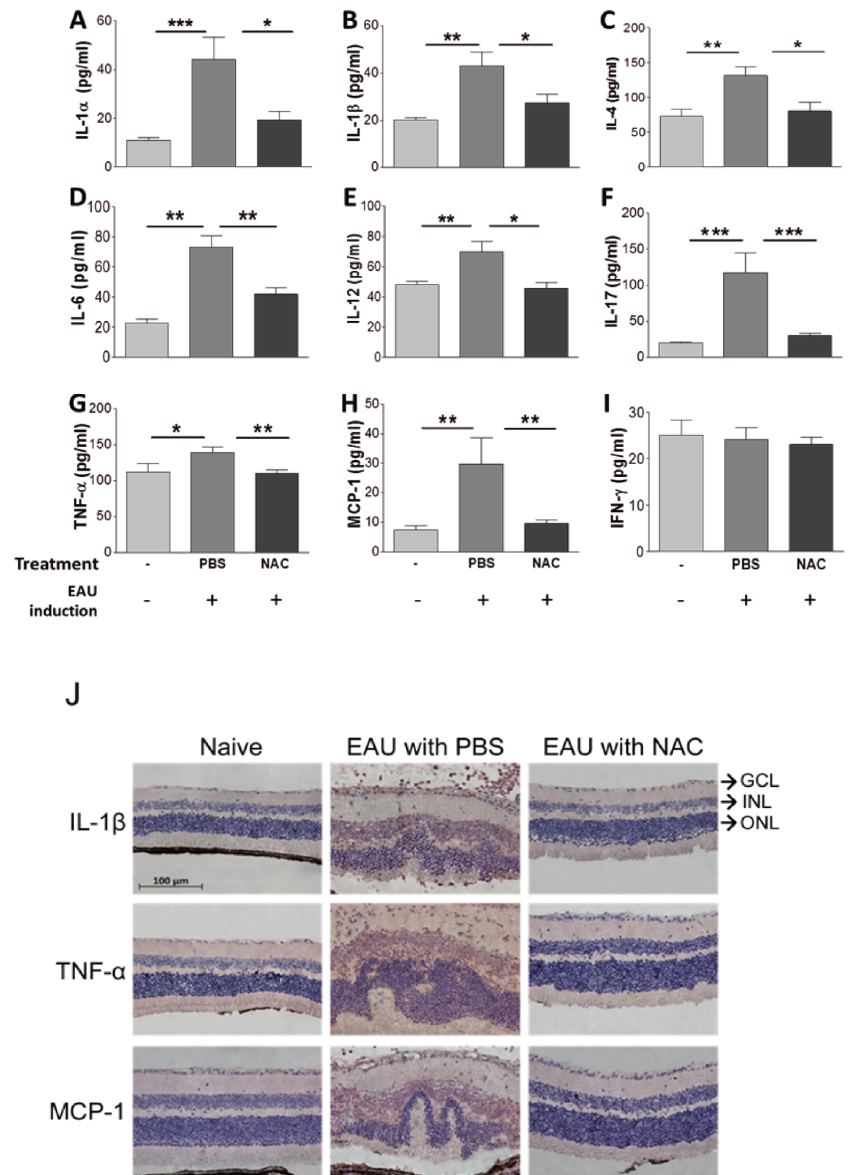
Figure 6. The influence of NAC treatment on the levels of inflammatory mediators in the retinas of mice with EAU induction. Levels of IL-1 α ( A ), IL-1 β ( B ), IL-4 ( C ), IL-6 ( D ), IL-12 ( E ), IL-17 ( F ), TNF- α ( G ), MCP-1 ( H ), and IFN- γ ( I ) in retinas of wild-type with ( + ) or without (-) EAU induction and treated with PBS or NAC are shown. Data show the mean + SE values (error bars) of > eight samples per group. * p < 0.05, ** p < 0.005, *** p < 0.001. ( J ) Eyes of wild-type mice without EAU induction (naïve) or with EAU induction and treated with PBS or NAC were subjected to staining for the indicated inflammatory mediators. The retinal portion is shown. Images are representative of at least four samples per group from two independent experiments. GCL, ganglion cell layer; INL, inner nuclear layer; ONL, outer nuclear